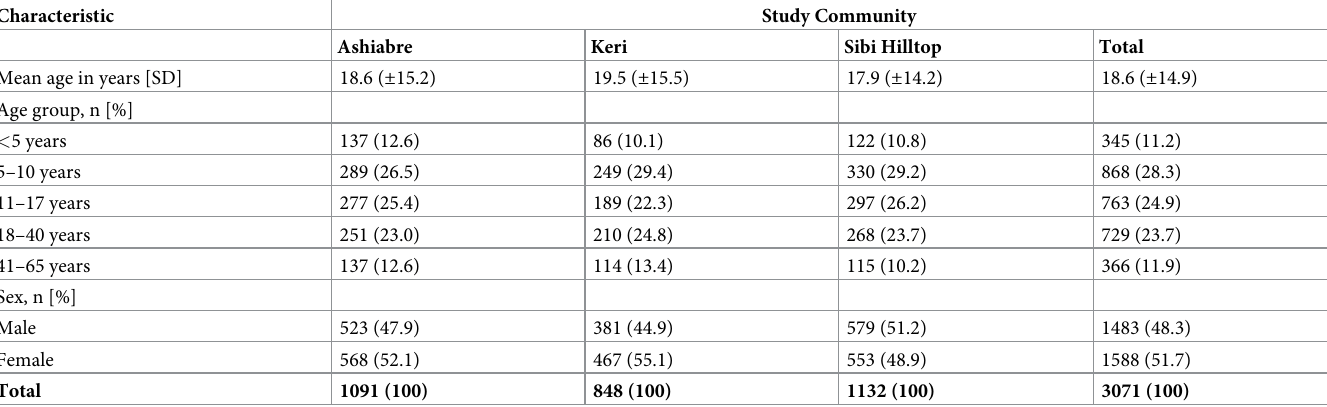
Table 1. Summary of study participants by age, sex, and community of residence.